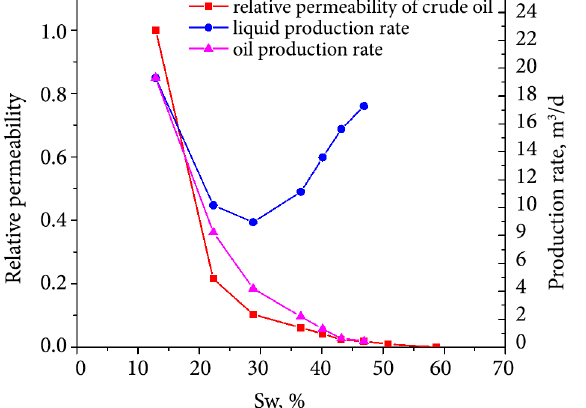
Figure 11. Comparison of the calculated production for different conditions of pressure-sensitive